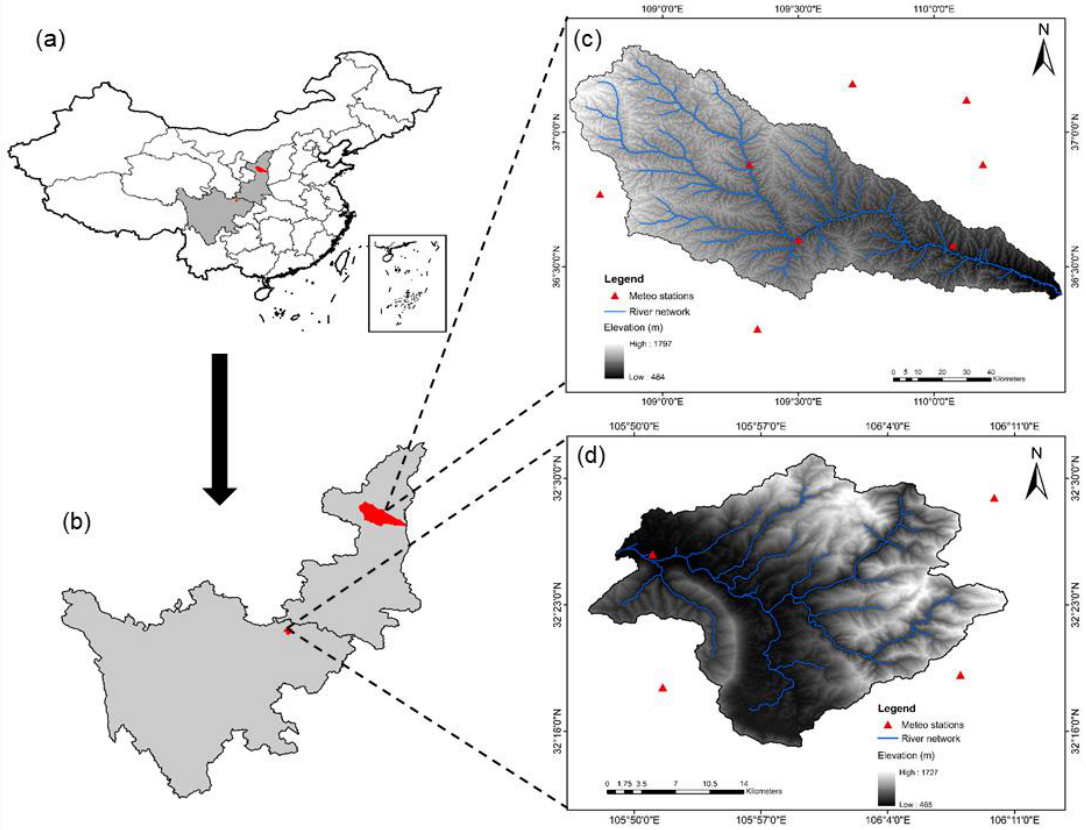
Figure 1. The location of the two study catchments used in this study in China ( a ), location of study area catchments in Shaanxi and Sichuan provinces ( b ), respectively, the Yanhe ( c ) and Guangyuan ( d ) study area boundary; elevation with the stream network is shown with blue solid lines and red triangles represent meteorological stations.